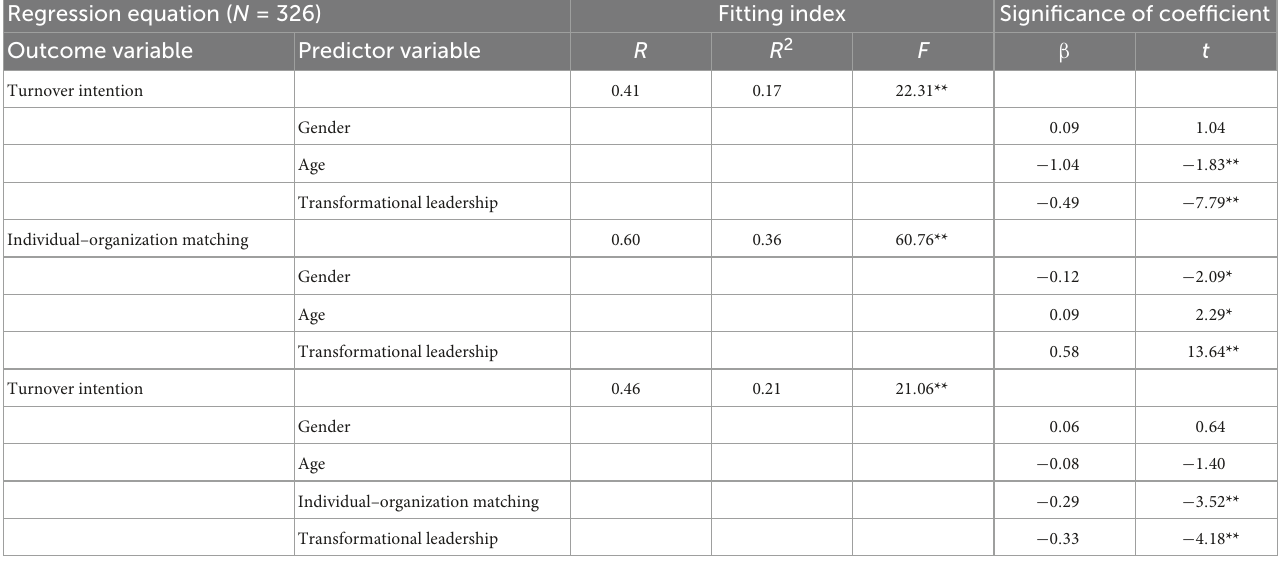
TABLE 5 Test of the mediating effect of person–organization matching. Regression equation ( N = 326)